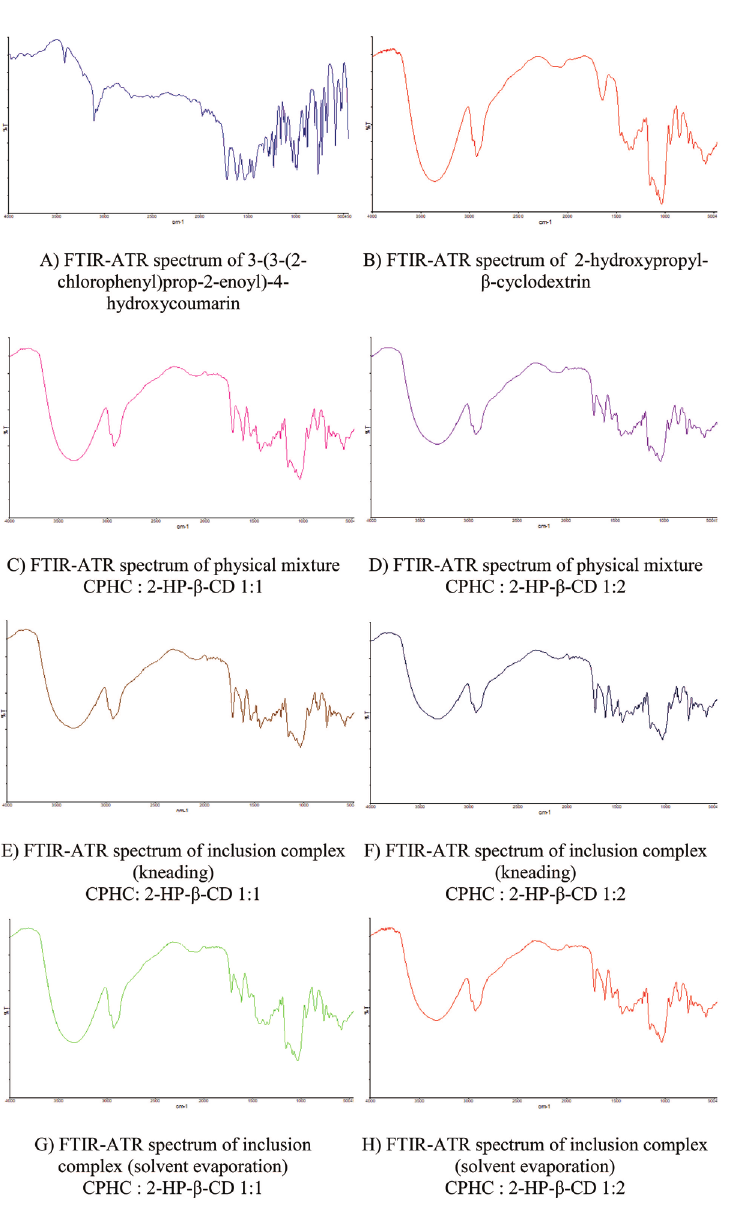
FIGURE 9 - FTIR-ATR spectra in the 4000 - 450 cm -1 range of A) CPHC, B) 2-HP-β-CD, C) PM CPHC : 2-HP-β-CD 1:1, D) PM CPHC : 2-HP-β-CD 1:2, E) KN CPHC : 2-HP-β-CD 1:1, F) KN CPHC : 2-HP-β-CD 1:2, G) SE CPHC : 2-HP-β-CD 1:1, H) SE CPHC : 2-HP-β-CD